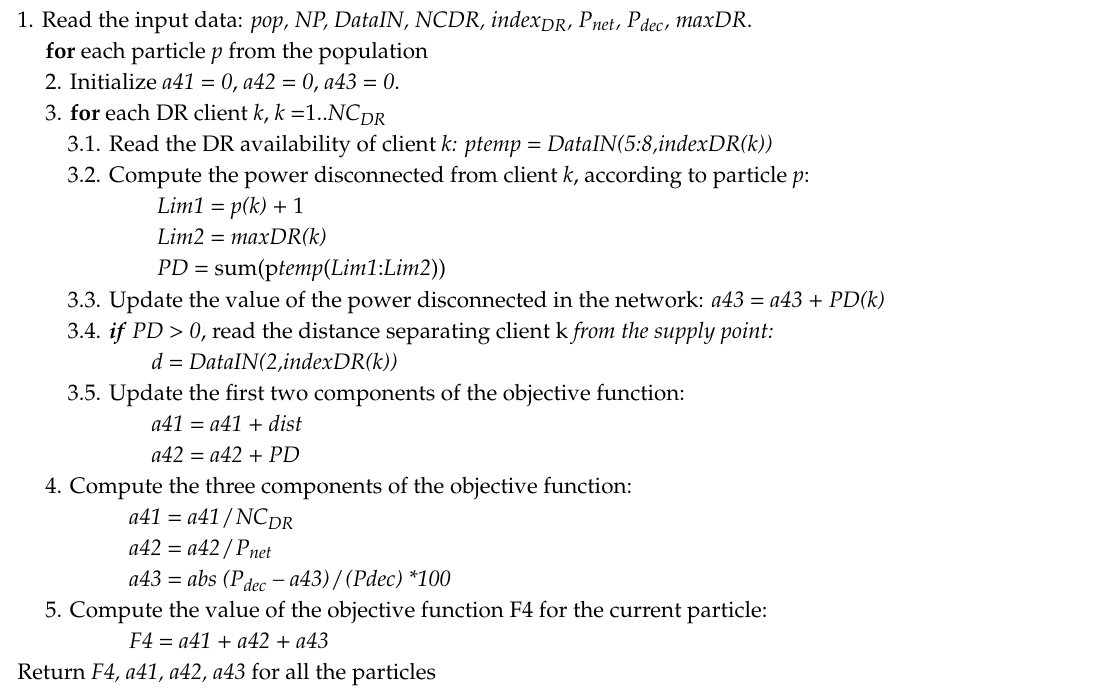
Algorithm 1. The subroutine used to encode the calculation steps for the objective function F4—the simplified loss minimization method proposed in the